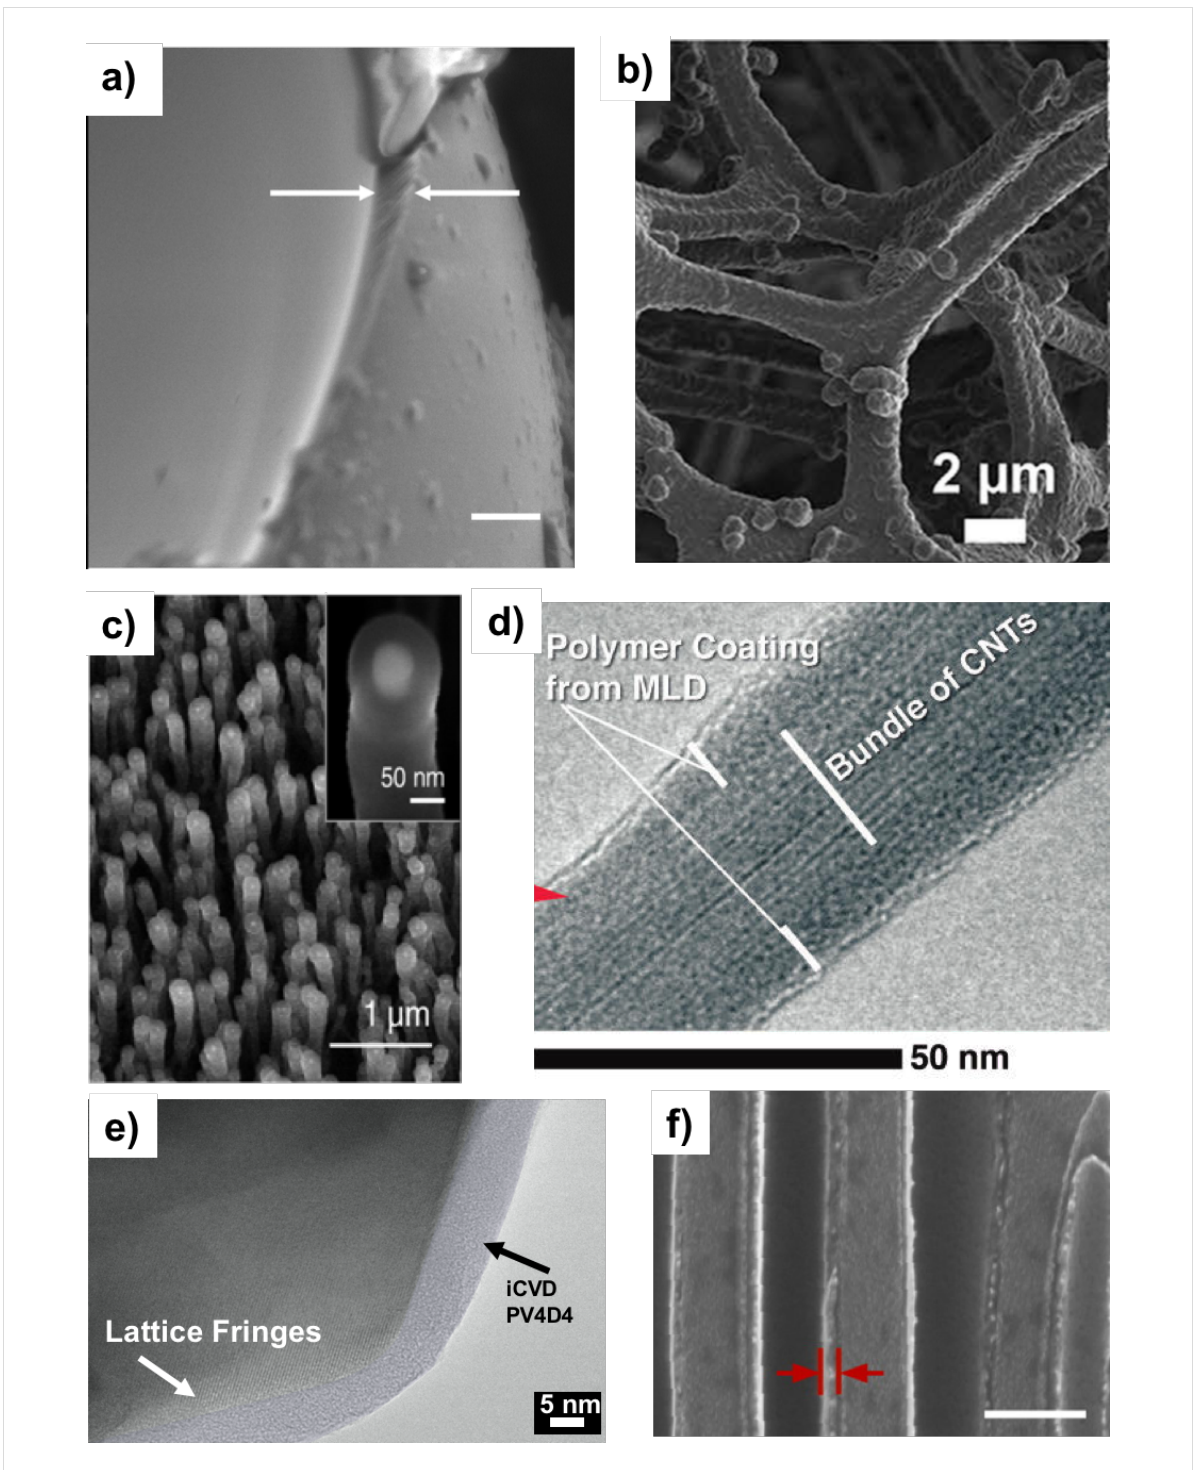
Figure 9: a) SEM image of silica micro-bead with conformal iCVD pHEMA coating, b) SEM image of commercial sponge with pHDFMA coating, c) SEM image of carbon nanotube forest with iCVD PTFE coating, d) TEM image of CNT bundle coated with MLD alucone coating, e) TEM image of lithium spinel oxide particle coated with iCVD pV4D4 coating, f) SEM image of NAA electrode with polythiophene coating (scale bar 200 µm). a) Reprinted with permission from [29], copyright 2008 American Chemical Society. b) Adapted from [46], Copyright 2016 Nature Publishing